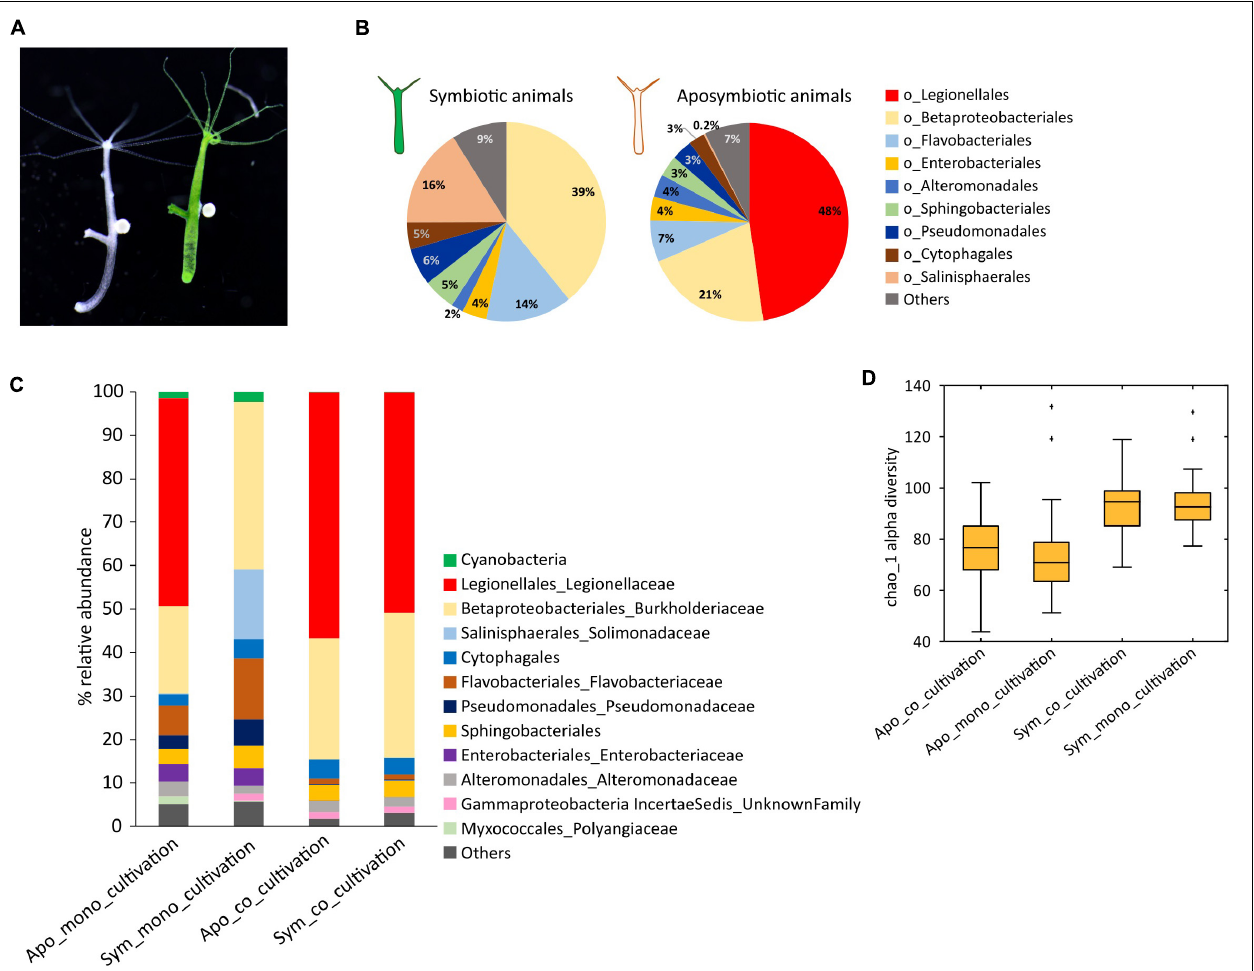
FIGURE 1 | Co-cultivation affects the microbiome composition of symbiotic and aposymbiotic Hydra viridissima ( H. viridissima ) polyps. (A) Symbiotic (green) and aposymbiotic (white) Hydra viridissima polyps. (B) Pie charts showing the mean relative abundances ( N = 58) of bacteria at order level of symbiotic and aposymbiotic H. viridissima . (C) Taxonomic bar charts representing mean relative abundances of bacteria in co-cultivated and monocultivated symbiotic and aposymbiotic H. viridissima . Co-cultivation of symbiotic with aposymbiotic animals drastically affects the microbiome of symbiotic animals, in particular due to the acquisition of a single operational taxonomic unit (OTU), Legionella spp. Hvir . (D) Box plots showing the alpha-diversity (Chao1) of symbiotic and aposymbiotic polyps under mono- and co-cultivation.